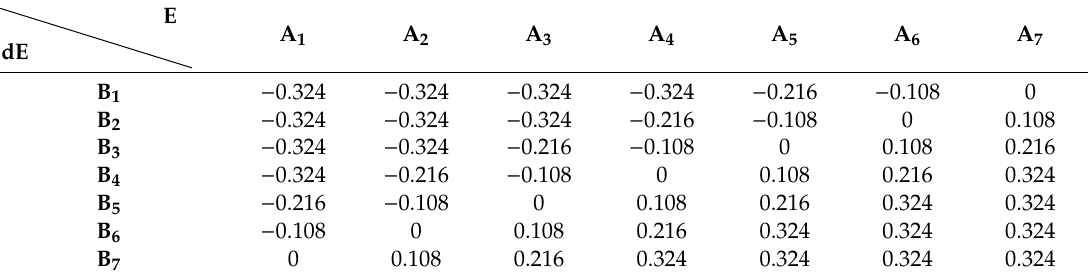
Figure 7. The overall simulation structure of the sensorless PMSM drive control system with a dynamic load system in MATLAB Simulink. Table 1. The initial fuzzy rule table of fuzzy logic controller